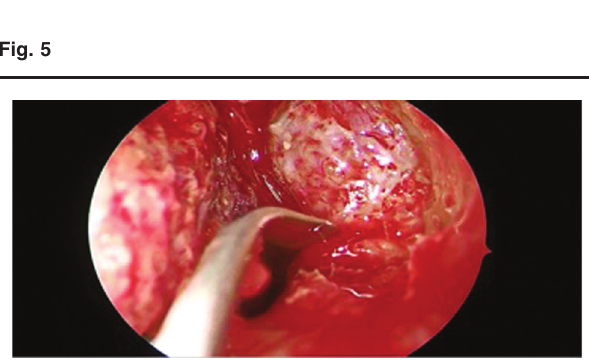
Inferior transverse incision throw medial wall of lacrimal sac by using keratome blade. Fig. 6